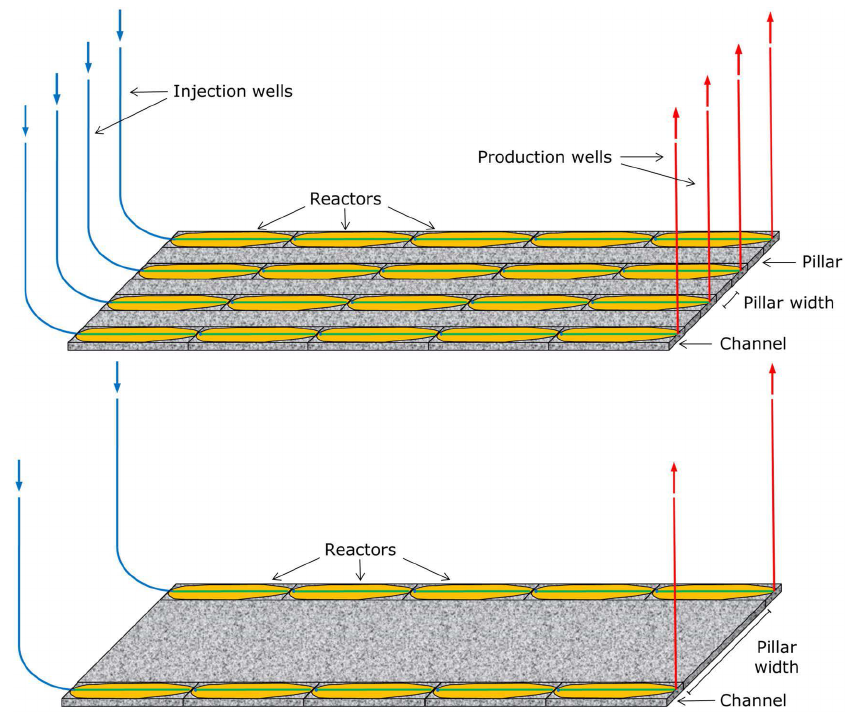
Figure 2. Conceptual design of the UCG CRIP (Controlled Retracting Ignition Point) methodology for different reactor-to-pillar-width ratios applied in our assessment: ratio of 1:3 (60 m pillar width) ( top ); and ratio of 1:7 (140 m pillar width) ( bottom ), modified after Blinderman